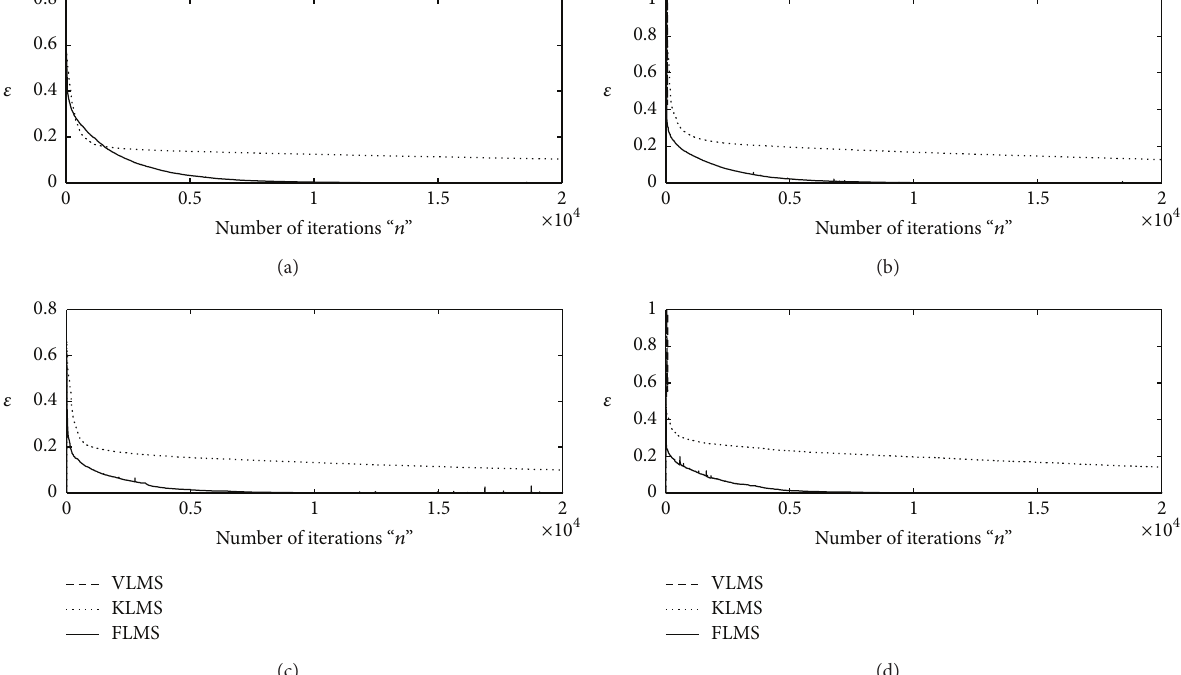
Figure 2: Iterative adaptation of merit function by VLMS, KLMS, and FLMS for fr = 0.5 algorithms for 𝜇 ∈ (10 −03 , 10 −05 ); (a) for SNR = 30 dB, (b) for SNR = 20dB, (c) for SNR = 10, and (d) for SNR =